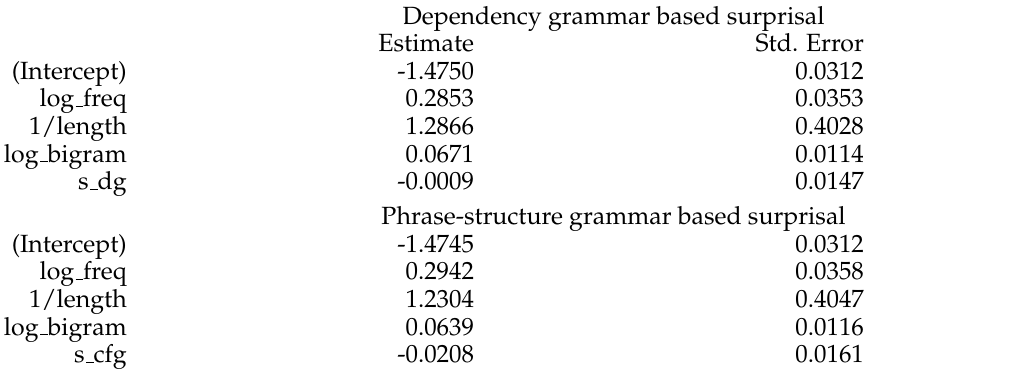
The effect on logit predictability of log unigram and bigram frequencies, 1/word length, and surprisal computed using the dependency grammar.